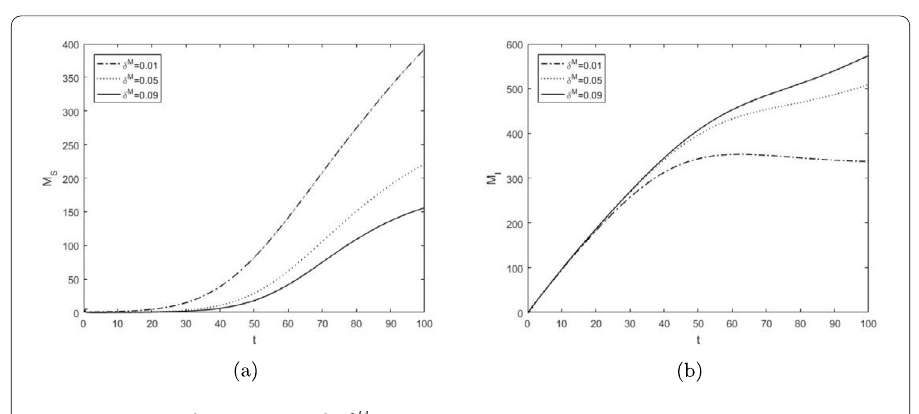
Figure 3 Variation of H S , H I , H R versus t for α = 0.75,0.667,0.50